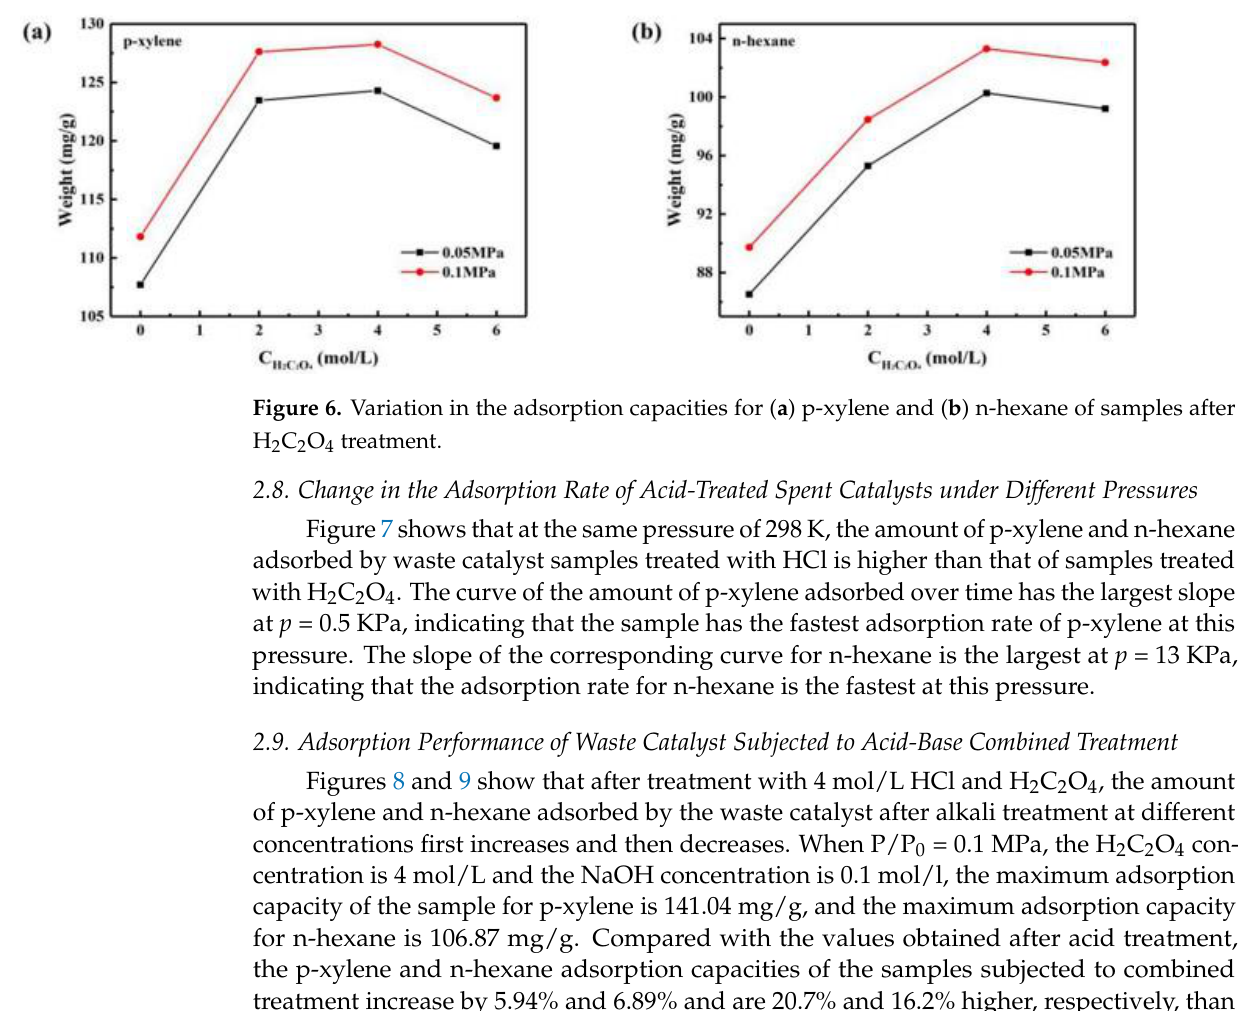
Figure 5. Variation in the adsorption capacities for ( a ) p-xylene and ( b ) n-hexane of samples after HCl treatment.